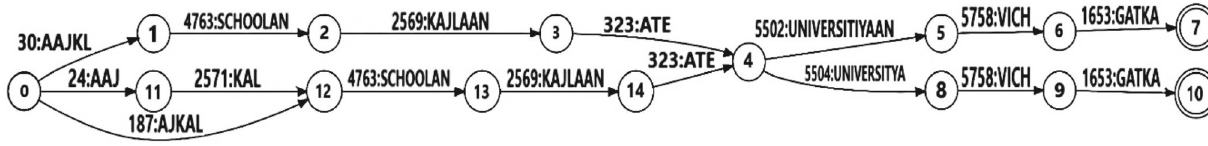
Fig. 6 Lattice network for word lattice in the speech